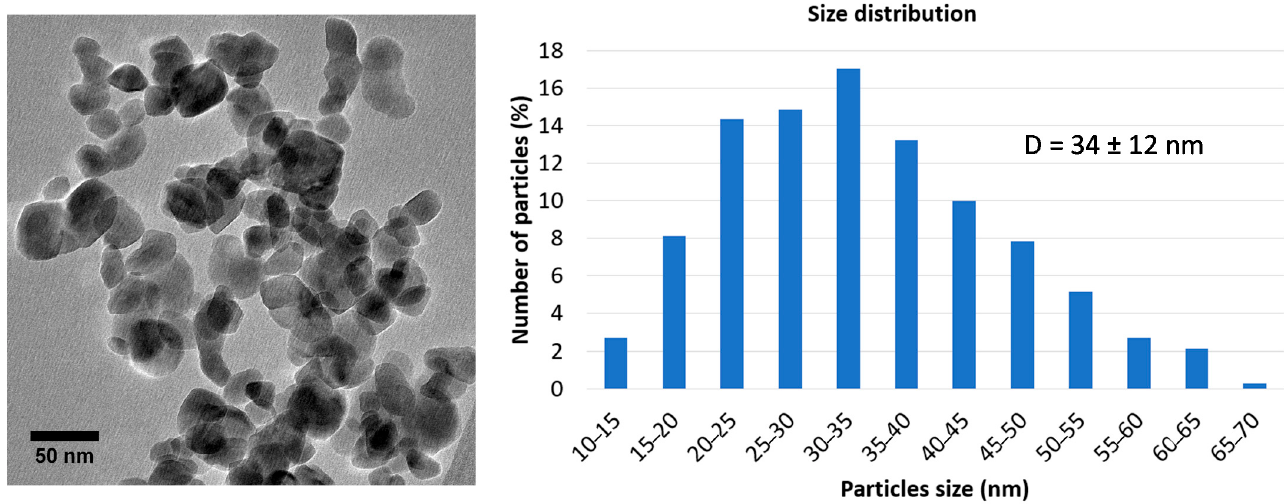
Figure A2. Representative TEM image of LN nanocrystals obtained after thermal decomposition of a mixture containing 5 mL of lithium niobium ethoxide in its parent alcohol and 3.8 mL of 1,4-butanediol. After considering 250 nanocrystals, we centered the corresponding histogram at 34 nm with a 12 nm standard deviation.